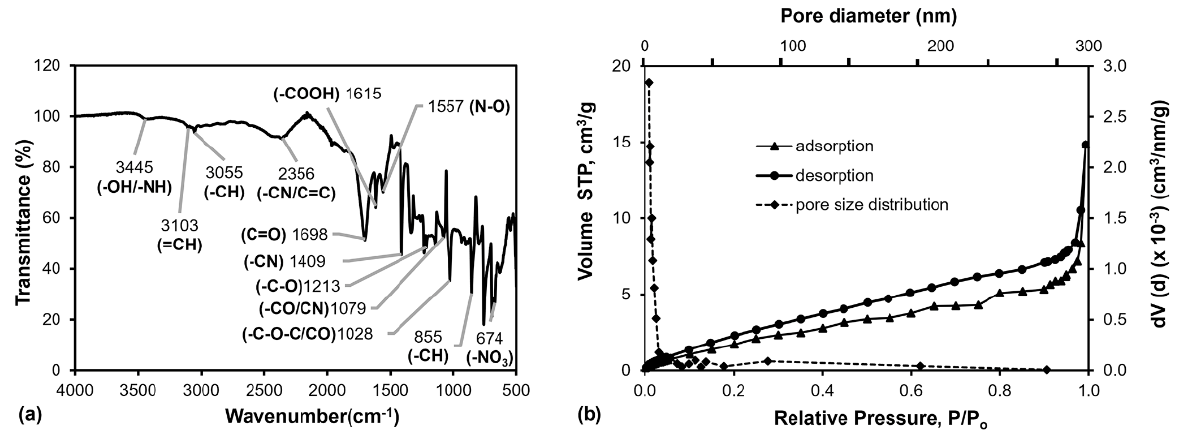
Figure 1. ( a ) FTIR spectra and ( b ) N 2 adsorption-desorption isotherms with the corresponding pore size distribution of the as-synthesized nanomaterial.